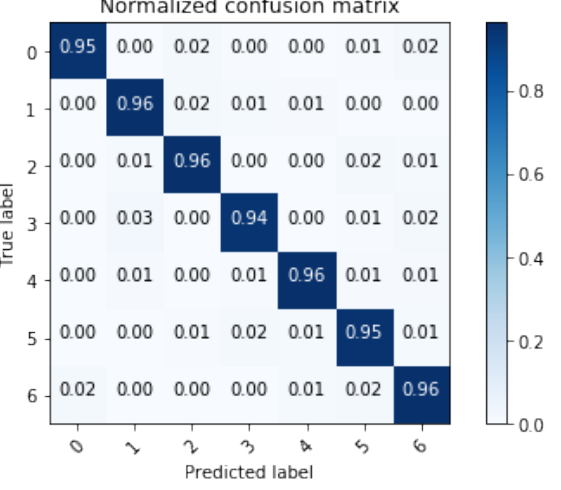
Figure 8. The confusion matrix of the related